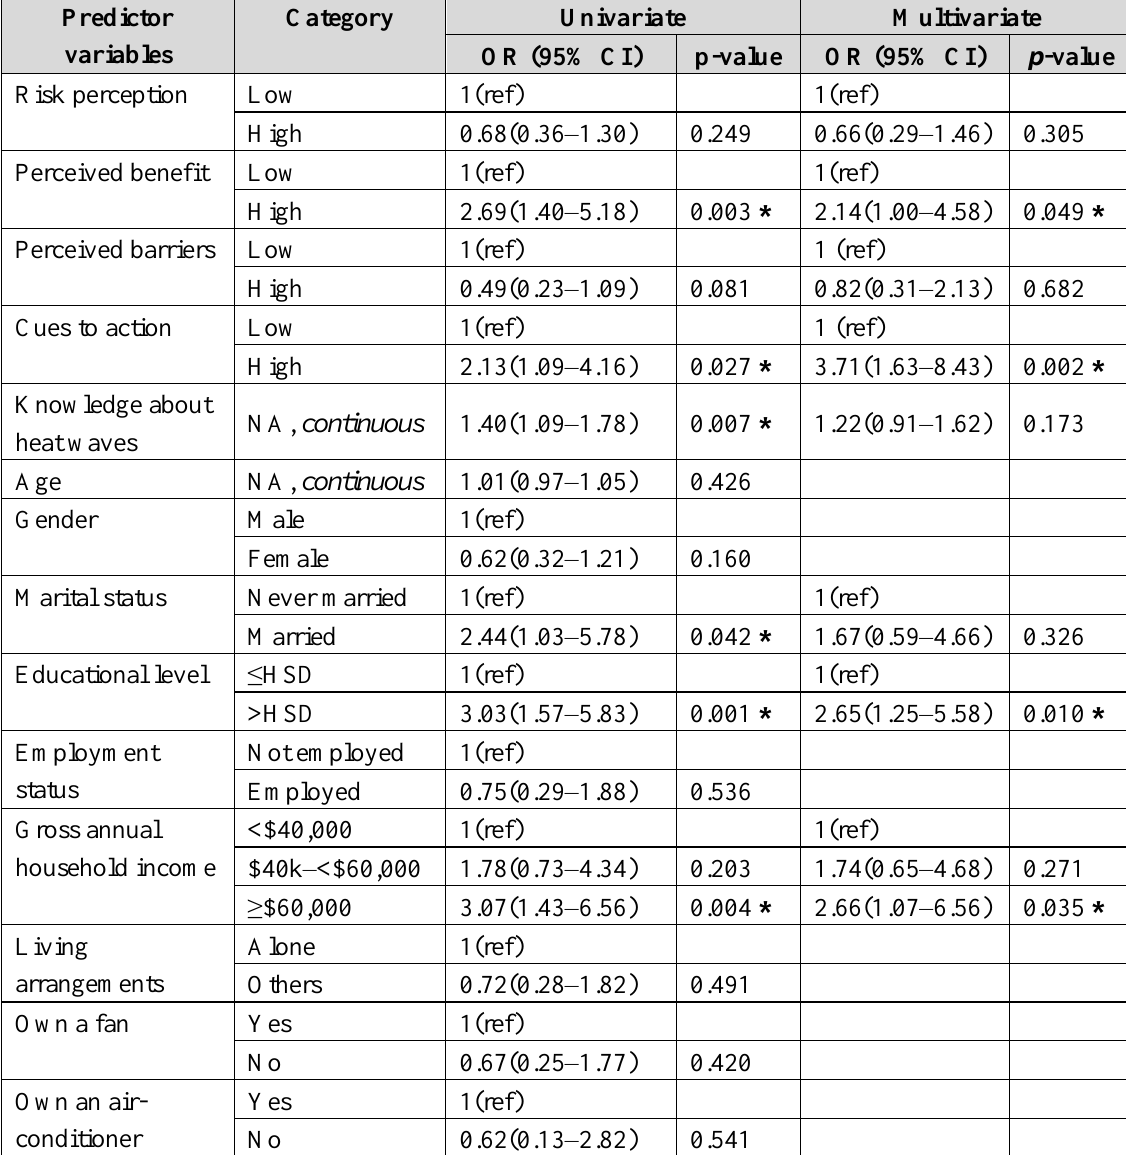
Table 8. Univariate and multiple logistic regression analyses for predictors of adaptive behaviours during a heat